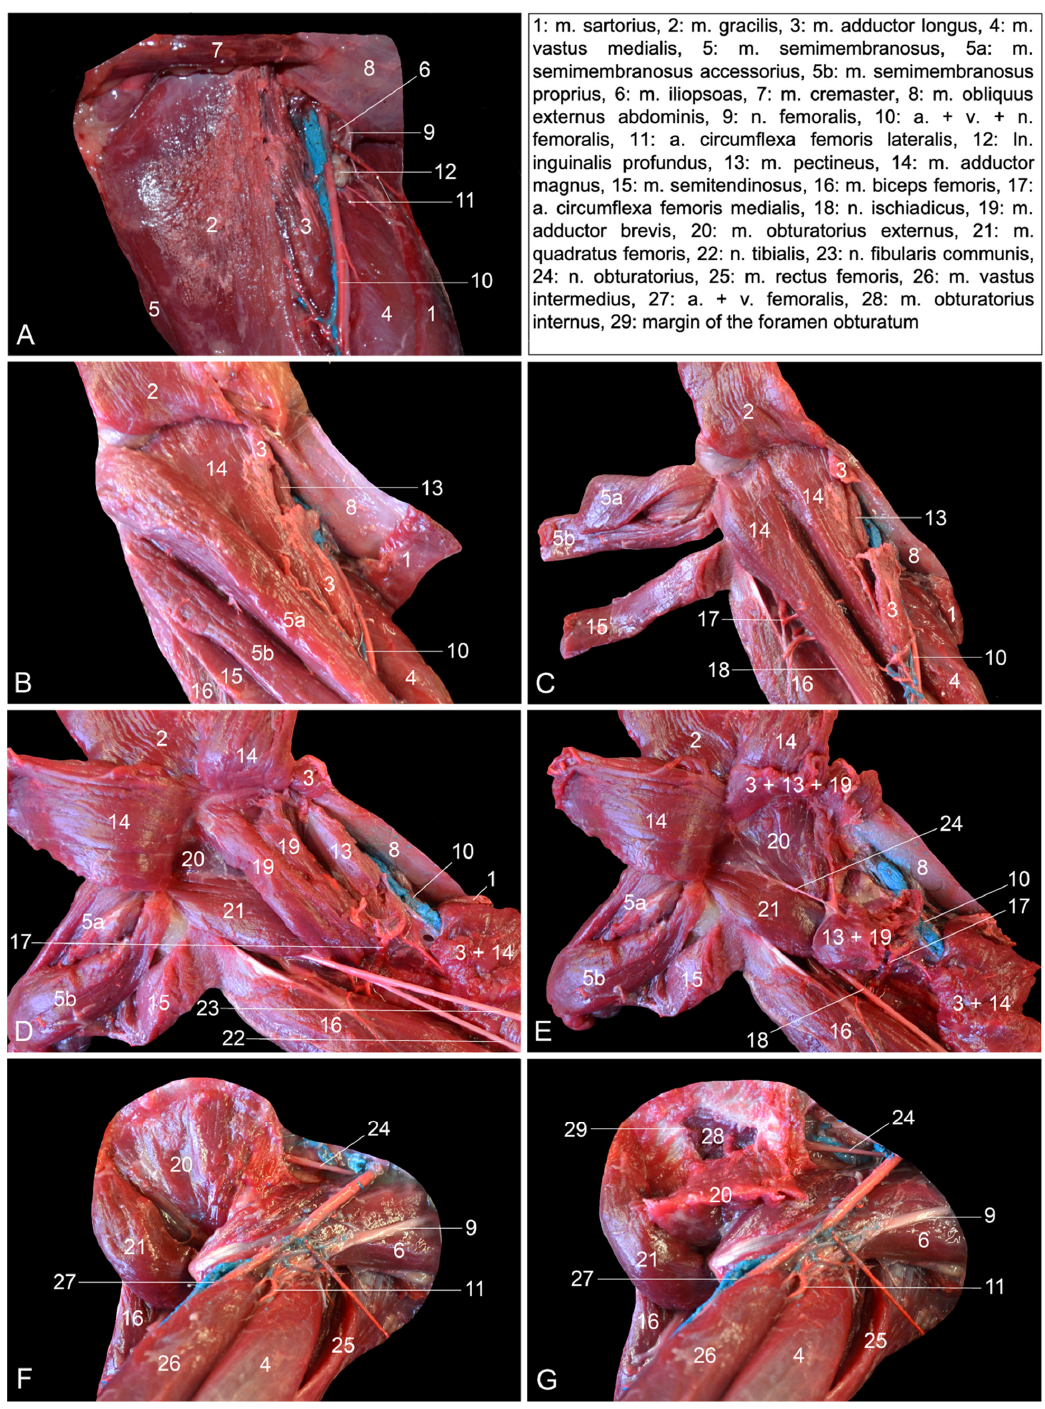
Figure 2. Ventromedial views of the left hip region. ( A ) Superficial layer, in which the m. sartorius is slightly retracted cranially; ( B ) second layer after the m. sartorius and the m. gracilis have been retracted; ( C ) third layer after the m. semimembranosus accessorius, the m. semimembranosus proprius and the m. semitendinosus have been retracted; ( D ) fourth layer after the m. adductor longus and the m. adductor magnus have been retracted; ( E ) fifth layer after the m. pectineus and the m. adductor brevis have been retracted; ( F ) sixth layer after the resection of the muscle stumps of the previously retracted muscles; ( G ) deepest layer after the m. obturatorius externus has been